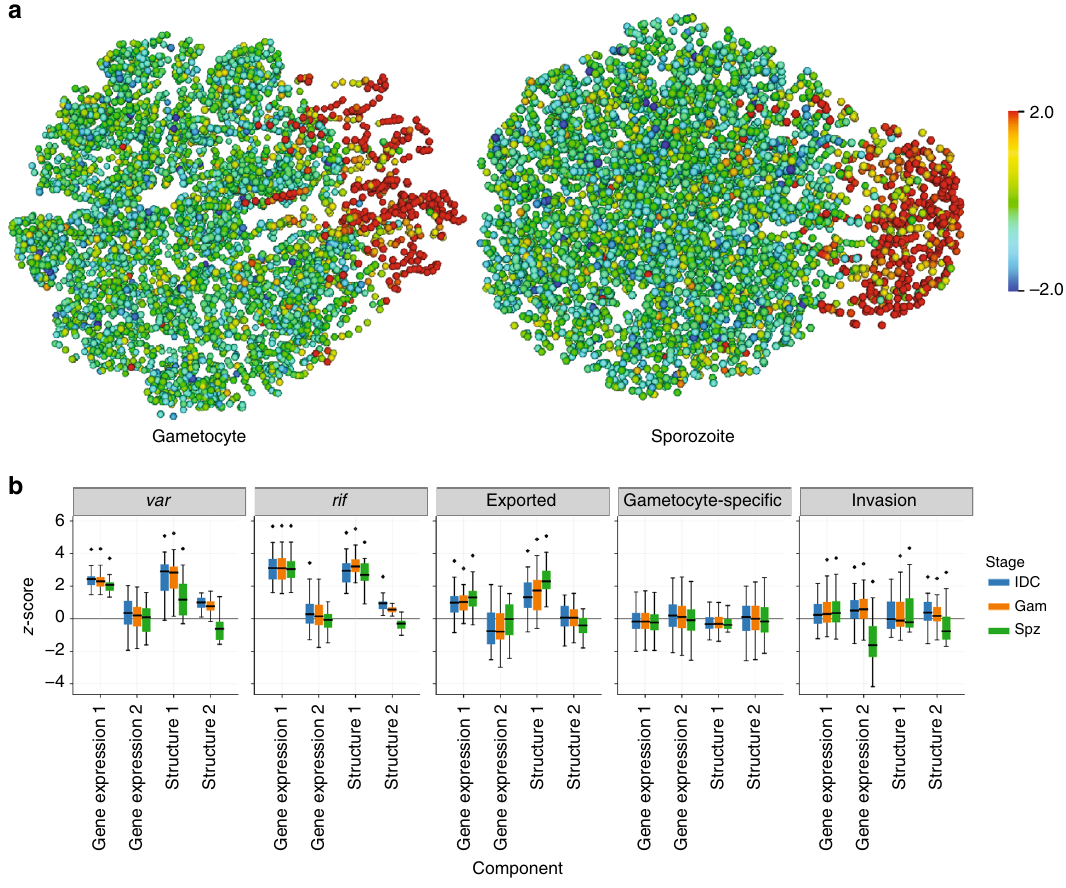
Fig. 6 3D genome structure correlates with gene expression. a Each gene is plotted by its position within the 3D structure and is colored by its standardized KCCA score (see Supplementary Information) in the fi rst gene expression component. The direction of this fi rst gene expression component is from the telomere cluster on the right to the opposite side of the nucleus and is dominated by the repressive center (genes colored in red). b The distribution of standardized KCCA scores for the fi rst and second gene expression components and the fi rst and second structure components of speci fi c groups of genes. The box plots show the median, fi rst and third quartile, and the minimum and maximum values. Diamonds indicate groups of genes for which the standardized KCCA scores for both the gene expression component and the structure component were signi fi cantly different ( t -test, FDR <